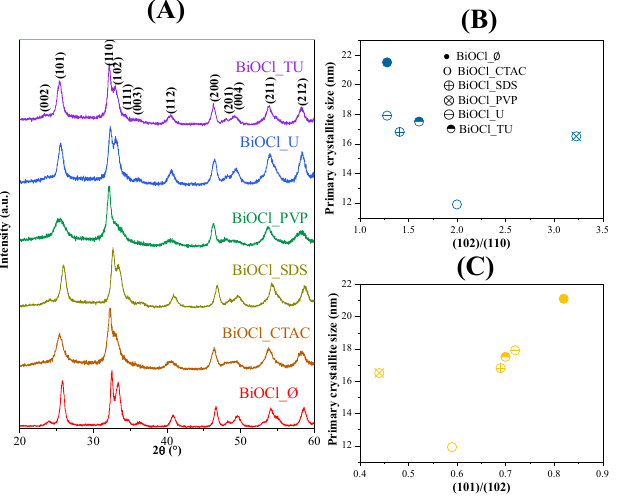
Figure 1. The XRD patterns of the BiOCl materials, using different additives ( A ) and the correla- tions between the primary crystallite size and (102)/(110) ( B ), (101)/(102) ( C ) and crystallographic planes’